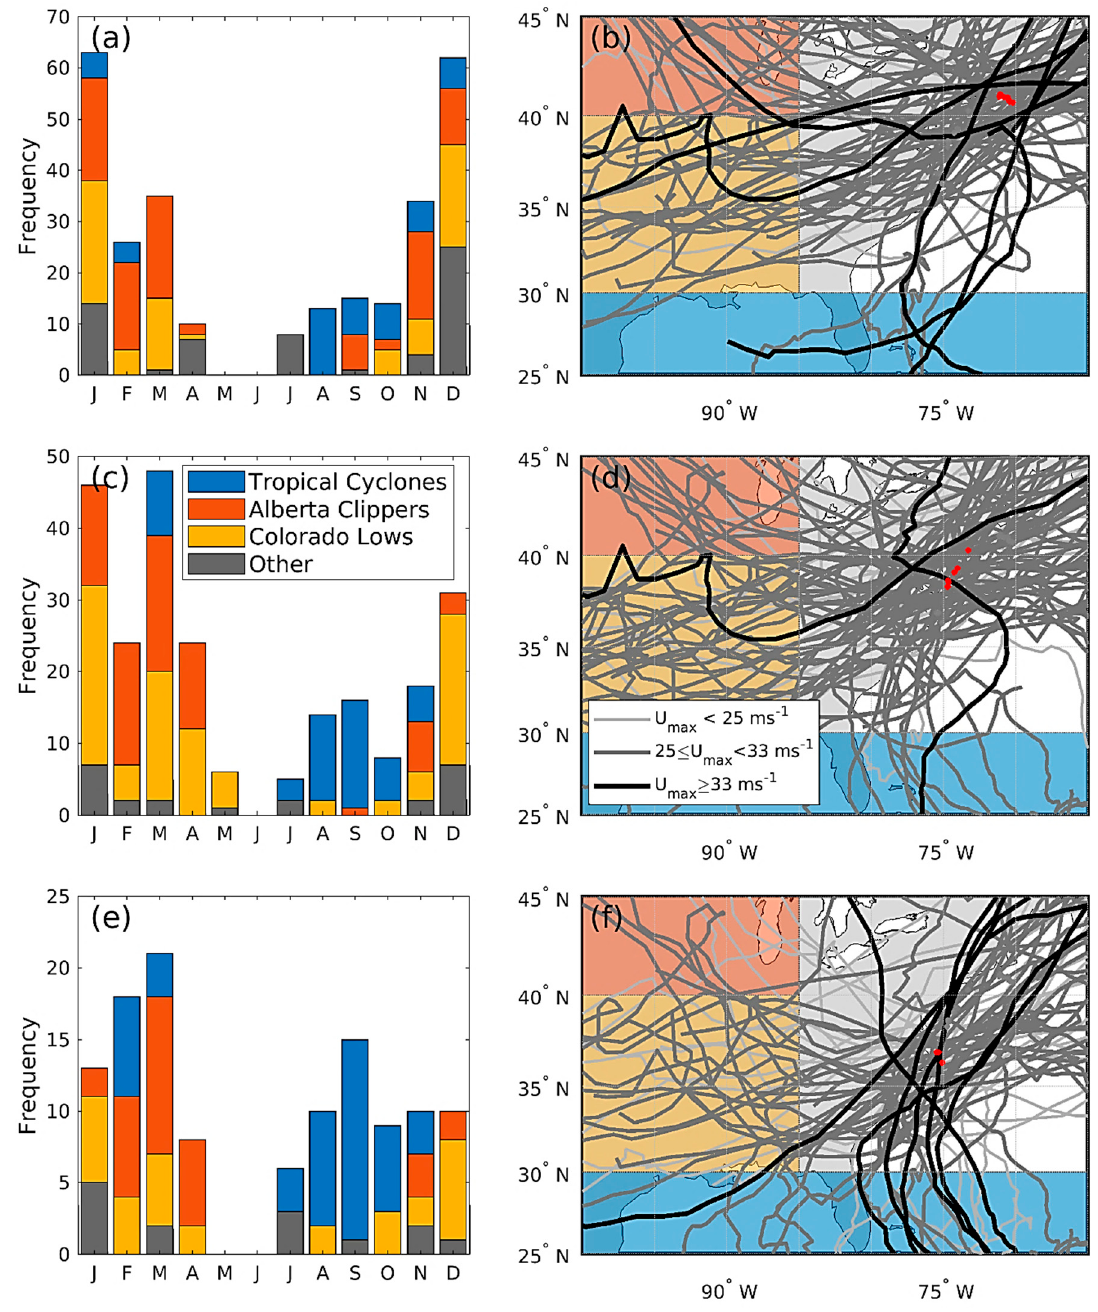
Figure 4. Histograms of the number of annual maximum wind events for each LA cluster by calendar month ( a ) North (LA 1–7), ( c ) Mid (LA 8–13), or ( e ) South (LA 14–16) associated with Tropical Cyclones (TC) (blue), Alberta Clippers (AC) (red), Colorado Lows (CL) (yellow) and ‘other’ (grey). Storm tracks that traversed the northern ( b ), mid ( d ) and southern ( f ) LA and resulted in all of the annual maximum wind speeds are shown in the right-hand panels and the shade of grey used encodes the value of the maximum wind speed in the LA (darkest denoting wind speeds in excess of 33 ms − 1 ). The cyclone origins are designated according to the geographic location in which the cyclone is first identified. The area from which AC originate is defined as 85 to 115° W, 30 to 40° N and is shown in red, the area from which CL originate is defined as 85 to 115° W, 40 to 75° N and is shown in yellow, TC are identified as being any storm that originate south of 30° N. All other cyclones are classed as ‘other’. LA centroids in each group are shown by red dots.